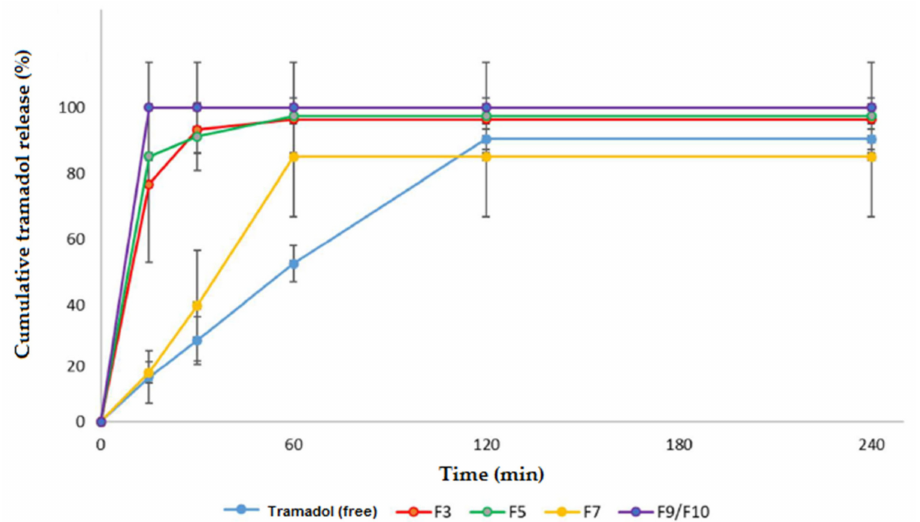
Figure 5. The effects of different amounts of polyvinyl alcohol (PVA), polyvinylpyrrolidone (PVP), and ethylcellulose (EC) on tramadol release from selected film formulations: F3, F5, F7, and F9/F10 and free tramadol. Each curve is the mean ± standard deviation of at least three